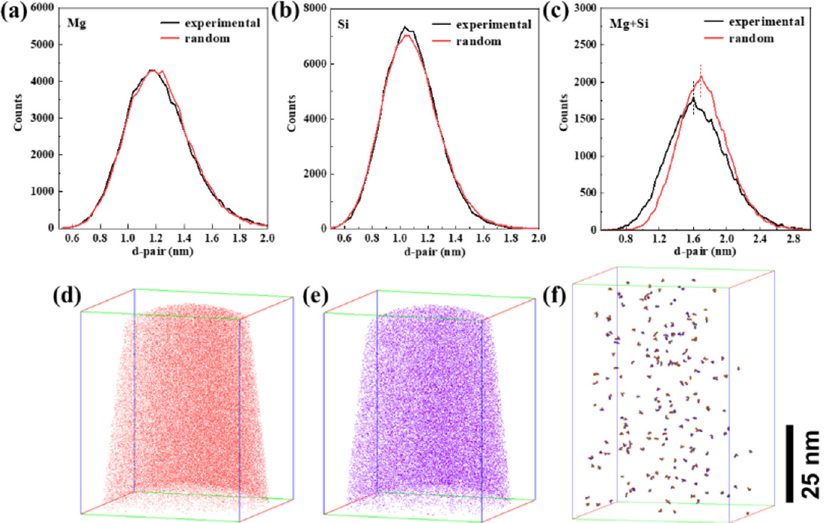
Figure 2. The 3 NN distribution of experimental and randomized data of NA10 min ( a , b ) and NA1440 min ( c ); And the 3D atom maps of Mg ( d ) and Si ( e ) of NA10 min and Mg + Si clusters of NA1440 min ( f ).